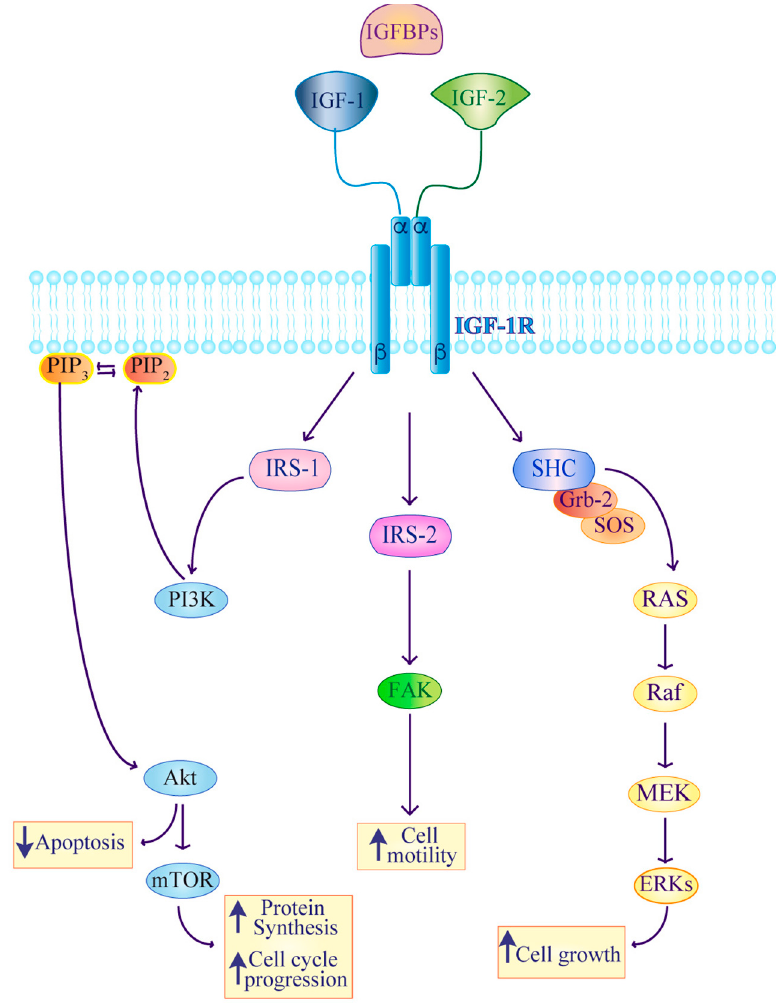
Figure 1. Schematic representation of the IGF-IR downstream signaling. Activation of IGF-IR is triggered by IGF1/2 ligands and modulated by IGFBPs. After ligand binding, IGF-IR recruits docking proteins including IRSs and SHC which induce the activation of intracellular modulators involved in: cell growth (RAS/RAF/MEK/ERK), protein synthesis, cell cycle progression (PI3K/AKT/mTOR) and cell motility [33]. Activated IGF-IR also inhibits apoptosis.